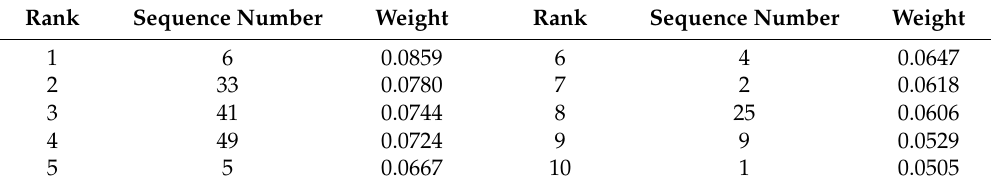
Table 8. Weights of the first 10 features in 2010.